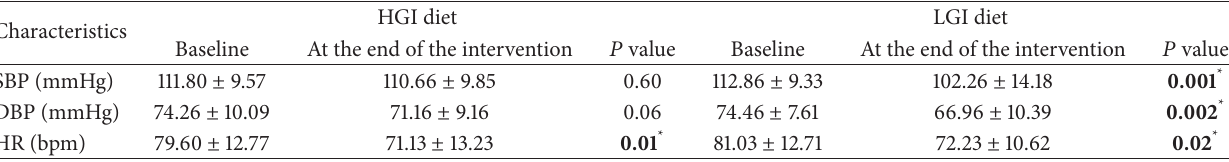
Table 4: The effects of LGI and HGI foods on SBP and DBP.